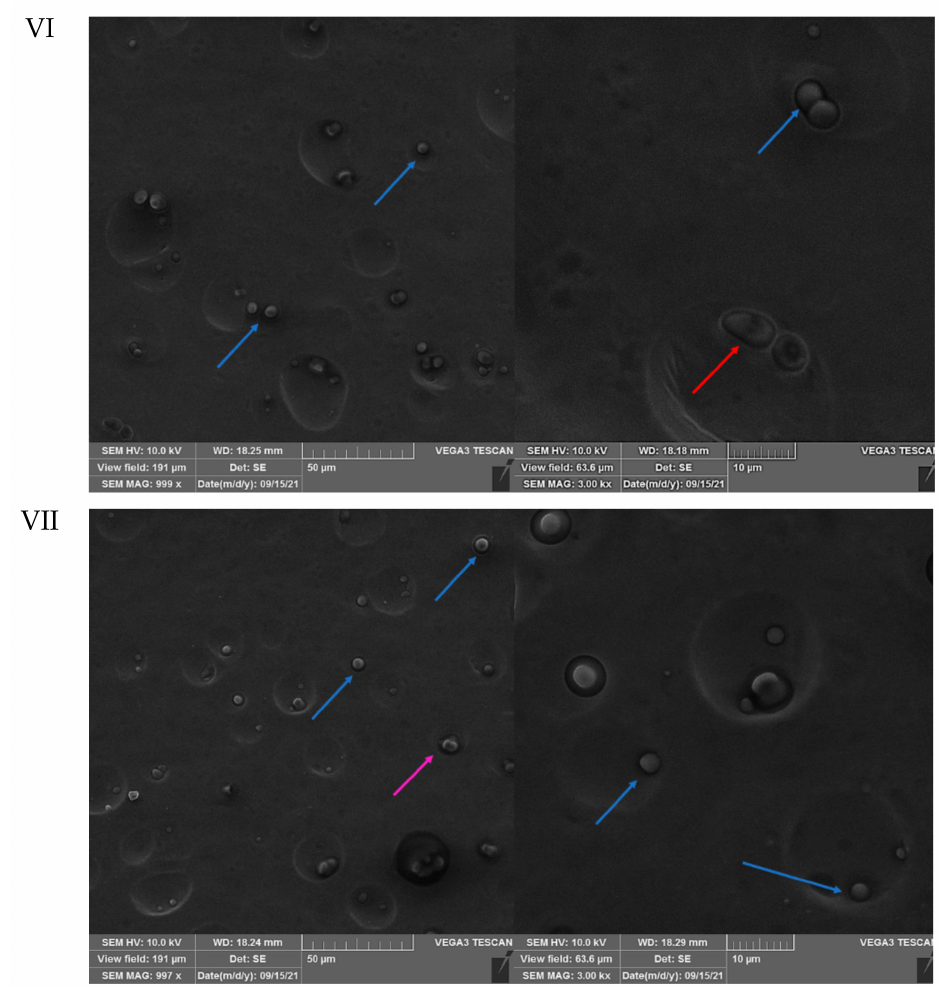
Figure 8. The SEM images the active coatings ( I – VII